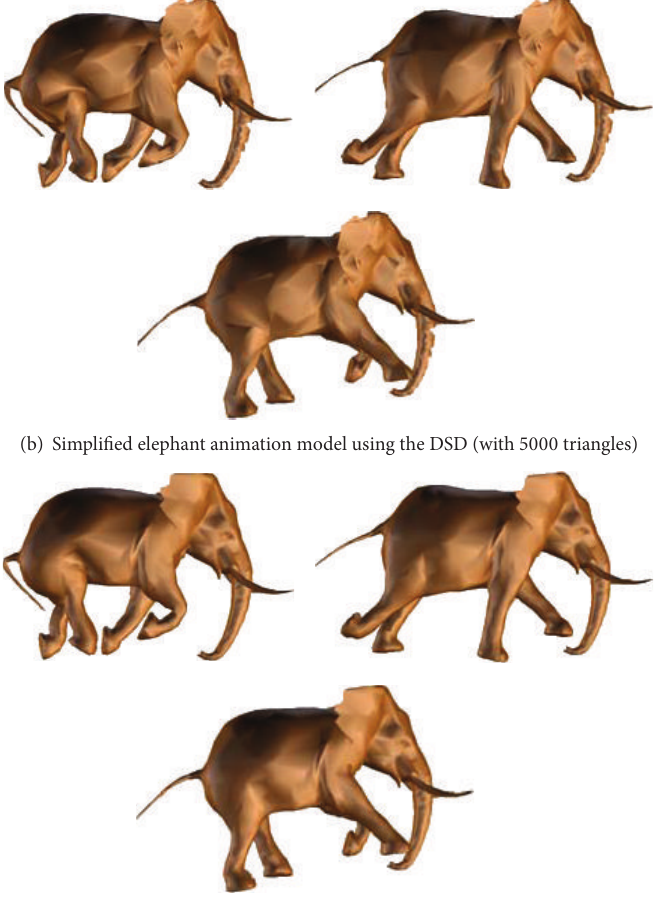
Figure 12: Simplification results of the elephant animation model (frame examples 5, 25, and